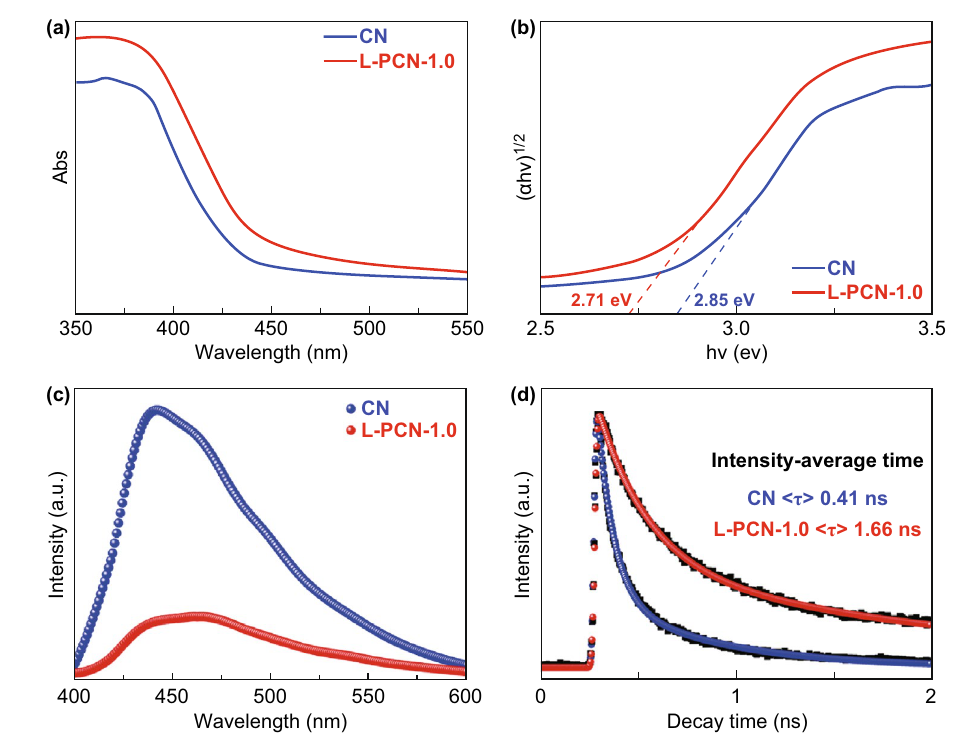
Fig. 5 Optical properties characterization of CN and L‑PCN. a UV–Vis DRS and b corresponding band gaps of CN and L‑PCN‑1.0 determined through the Tauc plots transformed from Kubelka–Munk function. c Photoluminescence emission spectra (with 350 nm excitation wavelength at room temperature) of CN and L‑PCN‑1.0. d Time‑resolved photoluminescence decay spectra of CN and L‑PCN‑1.0. These spectra were recorded with the excitation of 400 nm from a picosecond pulsed light‑emitting diode at room